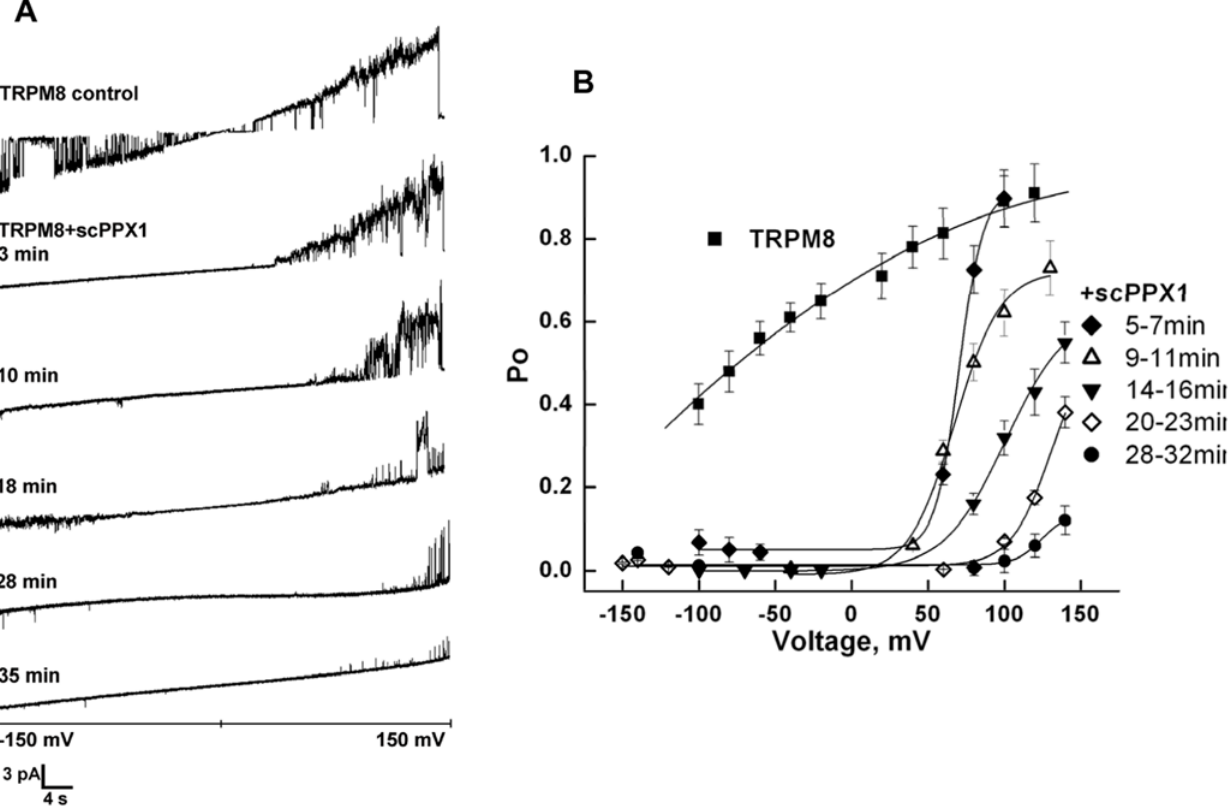
Figure 8. Voltage-dependence of TRPM8 before and after the treatment with scPPX1. A: Representative current traces recordings obtained at 2 150 + 150 mV voltage ramps before and after the treatment with polyphosphatase in a time course at the beginning of 3 rd , 10 th , 18 th , 28 th and 33 rd minutes. B: The changes in open probability obtained at different voltages in gap free recordings for TRPM8 alone ( & ) or after the treatment with scPPX1 for the following intervals of time: 5–7 min ( ¤ ), 9–11 min ( D ), 14–16 min ( . ), 20–23 min ( e ), and 28–32 min ( analyzed from overall of 16 experiments.